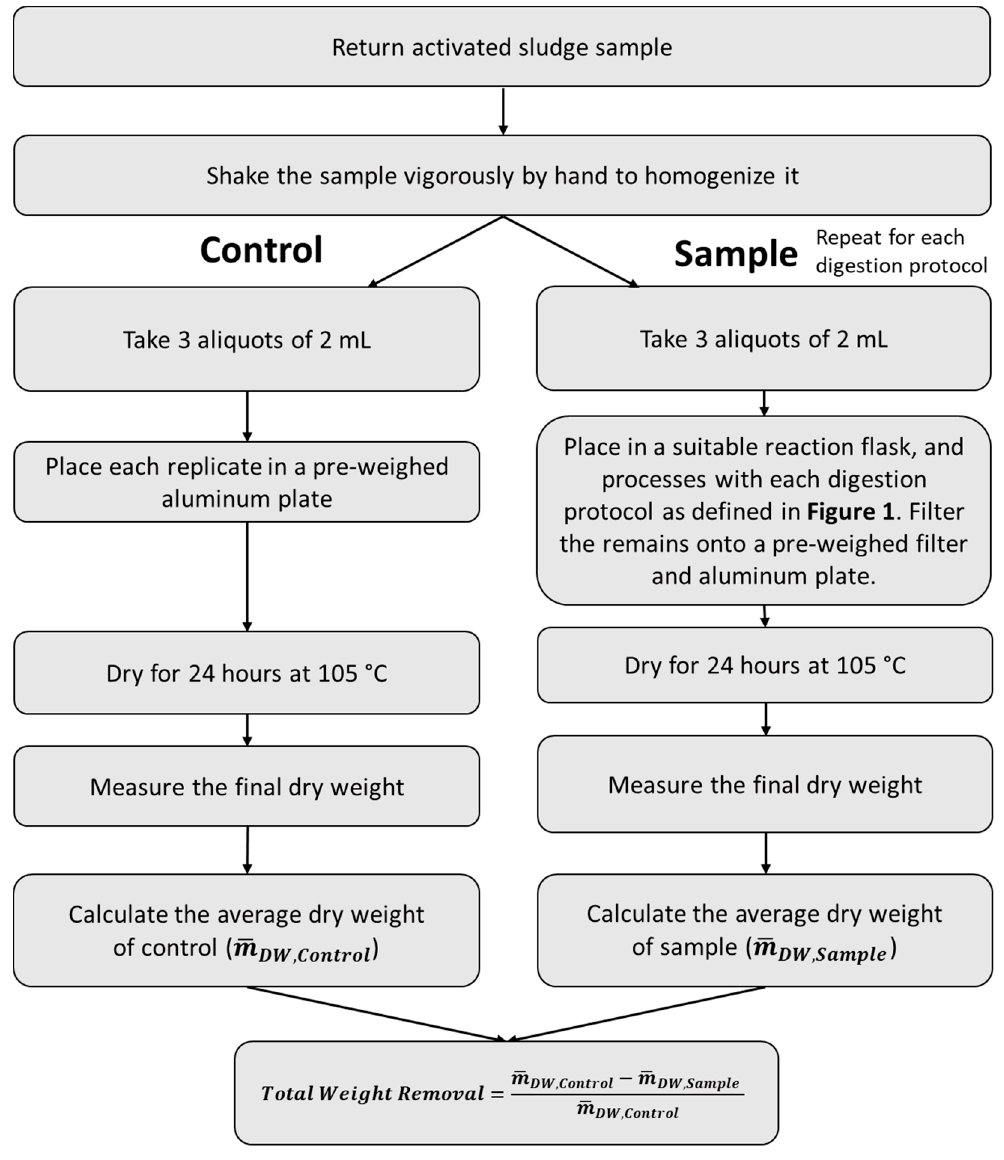
Figure 2. The workflow used in this study for investigating the organic matter removal e ffi